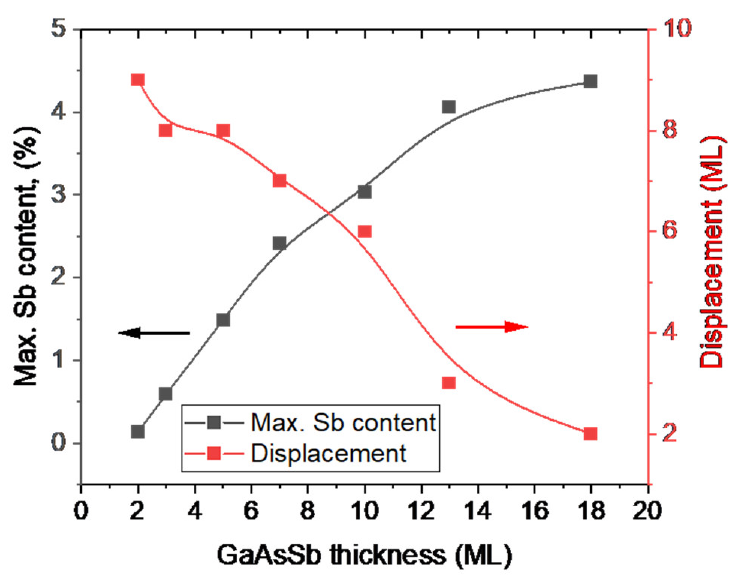
Figure 5. Maximum content (left coordinate, black squares) and displacement (right coordinate, red squares) of the peak maxima with respect to the position when the Sb flux is shut off, i.e., with respect to the nominal end of the GaAsSb layer, for the different periods.